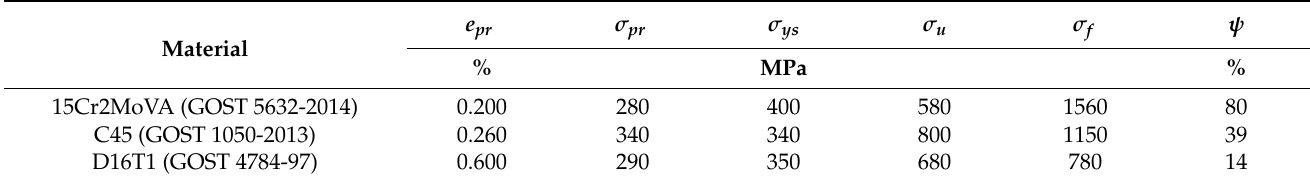
Table 2. Mechanical properties of the